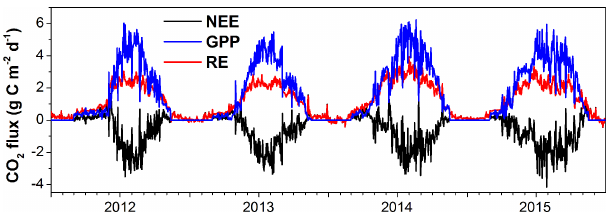
Figure 4. The daily mean NEE, GPP and RE from 2012 to